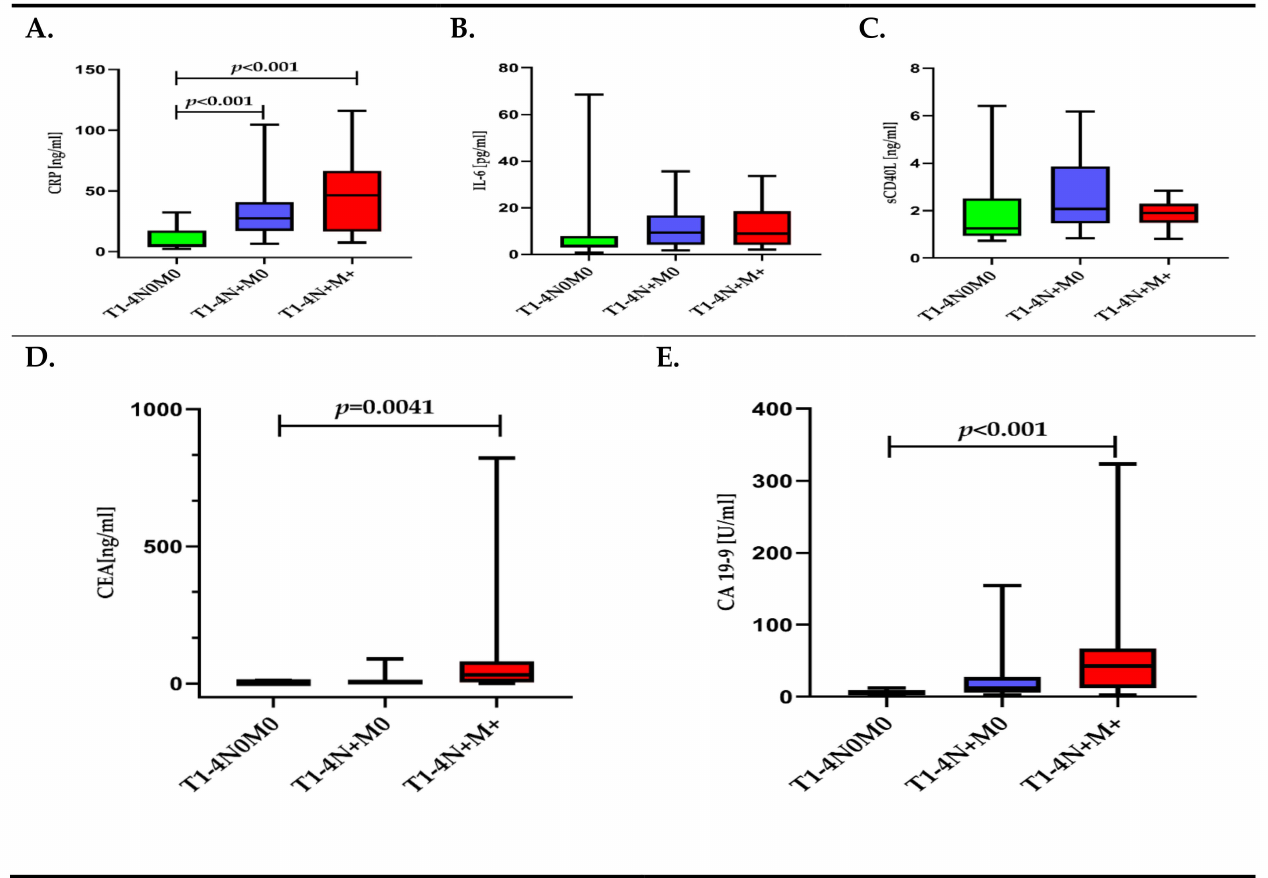
Figure 2. ( A – E ). Concentration of inflammatory response biomarkers (CRP, IL-6, sCD40L) and cancer biomarkers (CEA, CA 19-9) in colorectal cancer patients (CRC) depending on the TNM